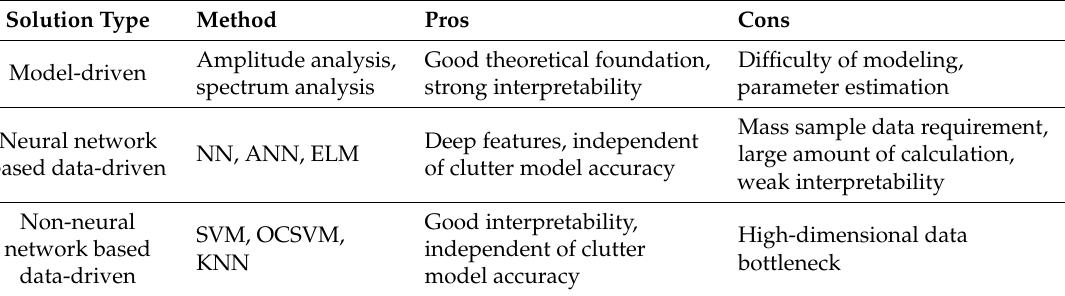
Table 1. Pros and cons of different types of classification